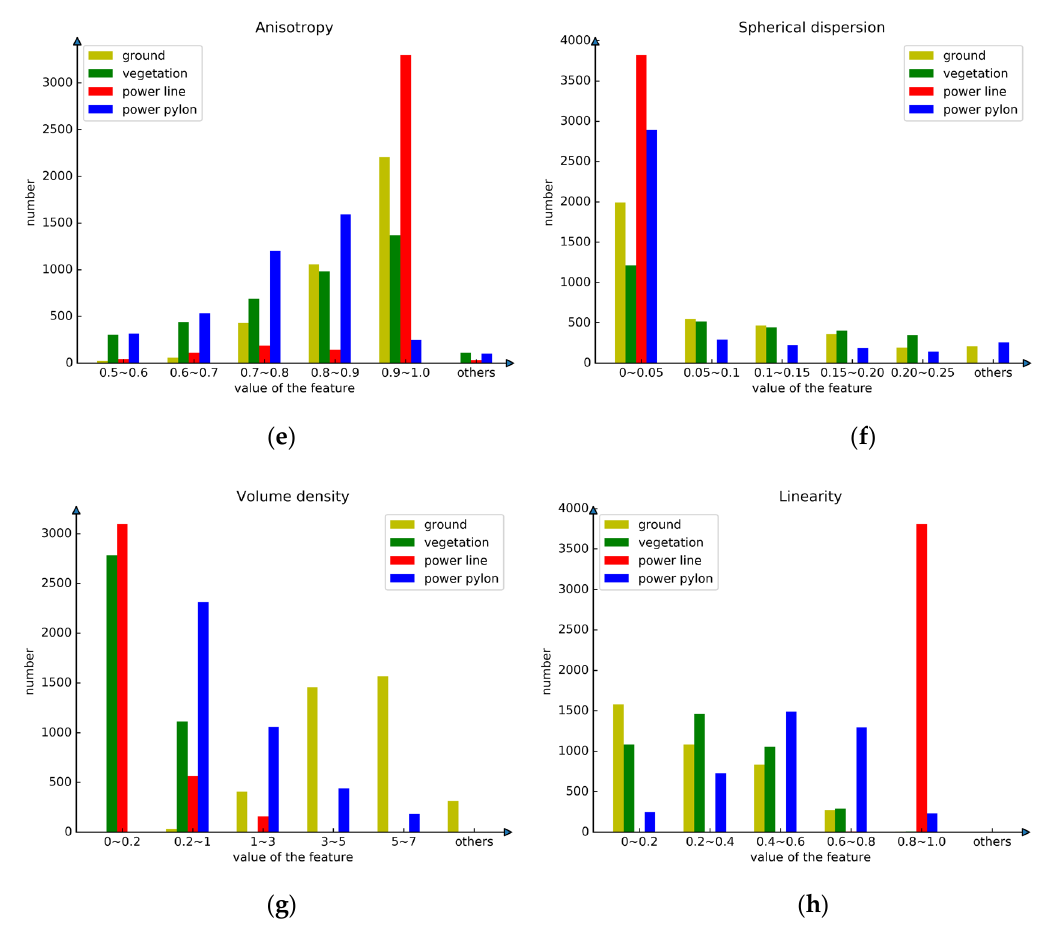
Figure 9. Comparison of point cloud features of four kinds of features.